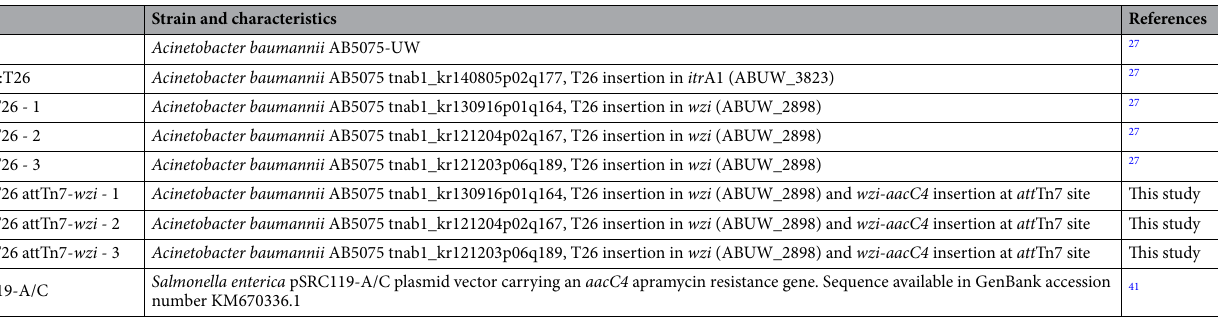
Table 1. Bacterial strains and plasmids used in this